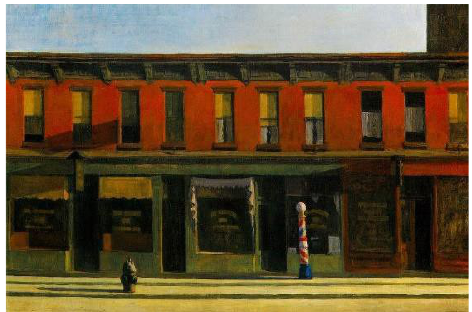
Fig. 16 Early Sunday Morning